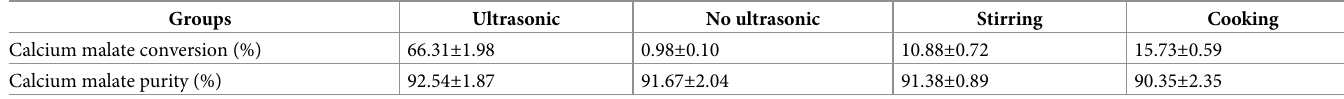
Table 3. The yield of calcium malate for treatment with different methods. Groups